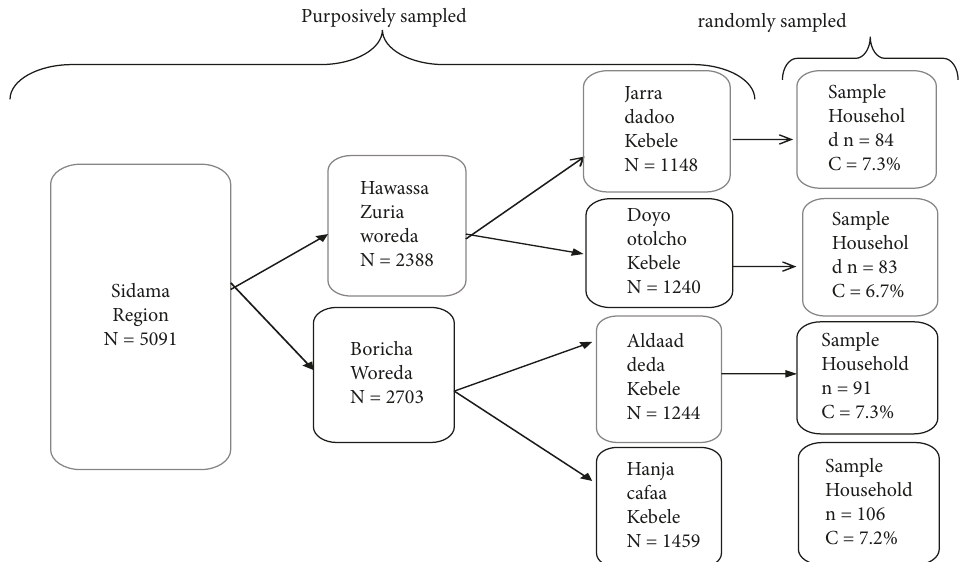
Figure 1: Total number of kebele households (N), number of sampled households (n), and the proportion of sampled households